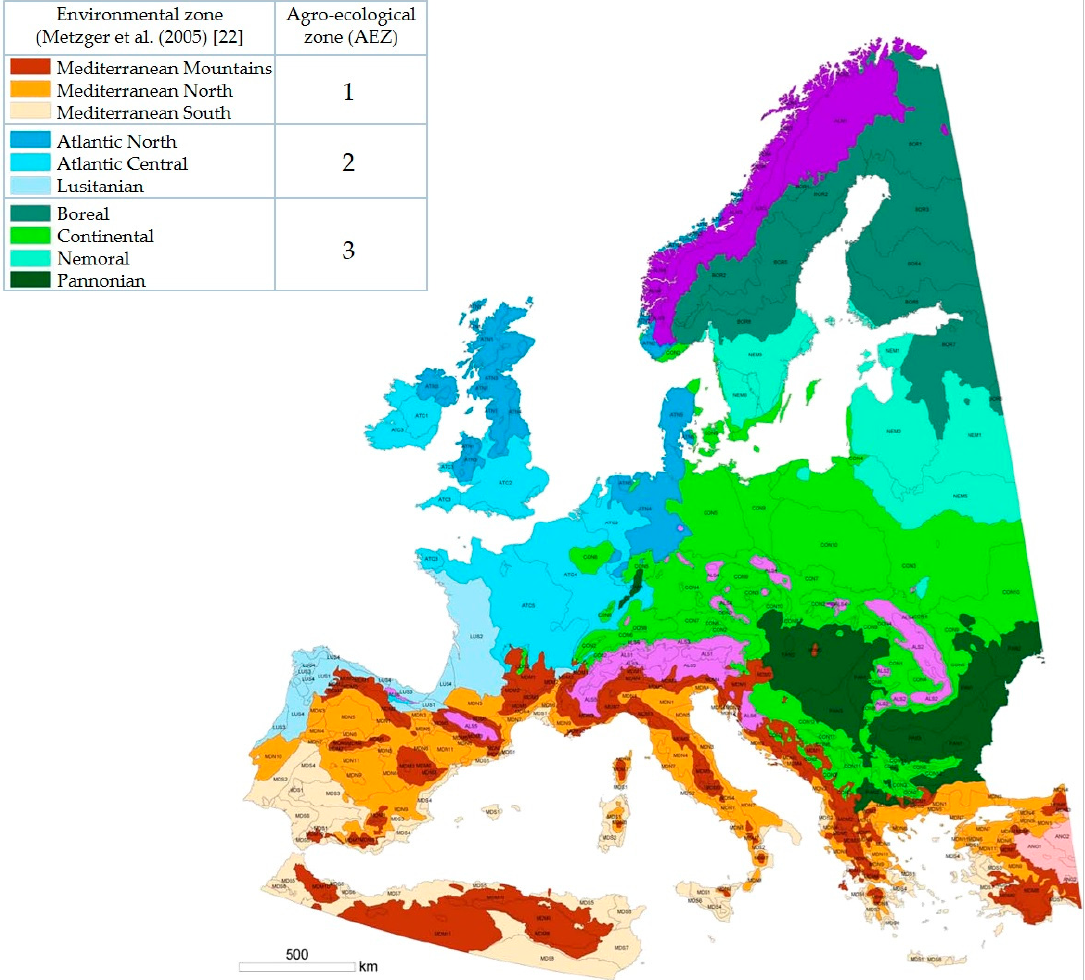
Figure 3. Distribution of agro-ecological zones (AEZ) taken into consideration for the development of marginal agricultural land low-input systems (MALLIS) for industrial crops across Europe (modified from Reference [34]). Table 2. Relevance of the constraints and constraint combinations expressed as agricultural area (km 2 ) per AEZ.